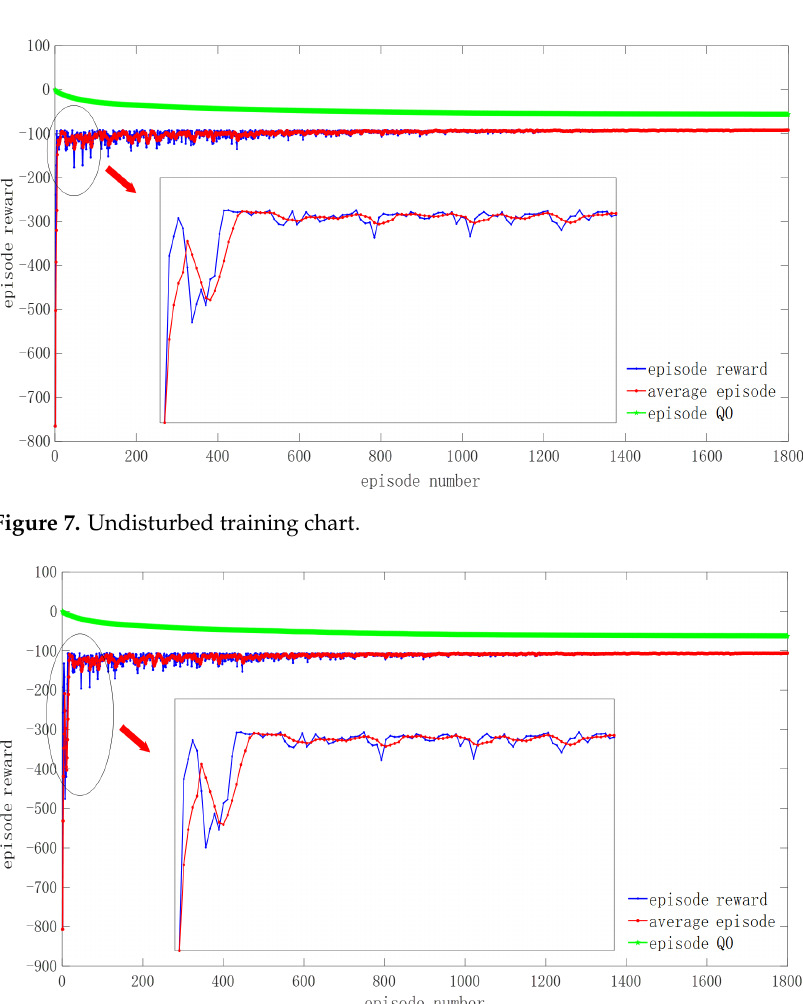
Figure 8. Diagram of disturbance